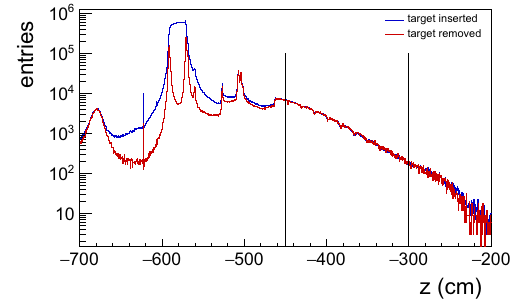
Fig. 2 Distributions of the z -coordinate of the reconstructed vertex for events recorded with target full (blue histogram) and target empty (red histogram). Two vertical black lines at position − 450 and − 300 cm